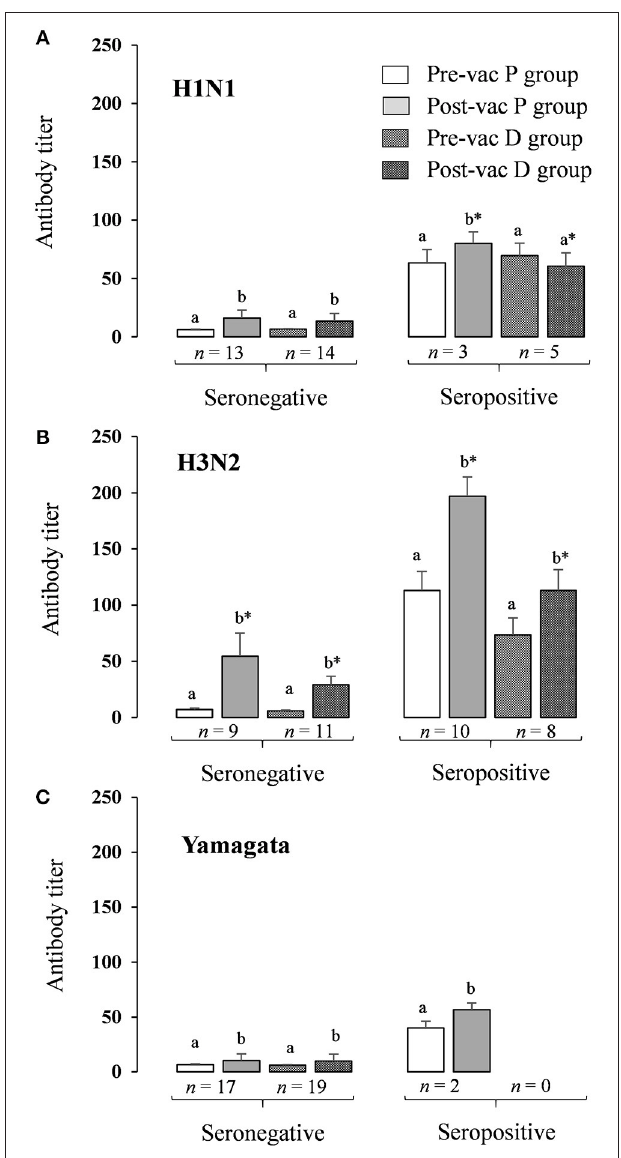
FIGURE 6 | HAI antibody titer response to inactivated influenza virus vaccine in seronegative and seropositive volunteers. HAI antibody titers stratified by pre- and post-vaccination status. (A) Antibody titers for H1N1 pandemic influenza A (A/California/7/2009, H1N1pdm09); (B) Antibody titers for H3N2 pandemic influenza seasonal influenza A (A/Texas/50/2012, H3N2); (C) Antibody titers for Yamagata seasonal influenza B (B/Massachusetts/2/2012, Yamagata lineage). Results are expressed as GMT (95% IC); a,b Significantly different between pre- and post-vaccination titers in the same group using paired Wilcoxon test ( p < 0.05); * Significantly different for a same period (pre- or post-vaccination) between P group and D group using Mann-Whitney U-test ( p <